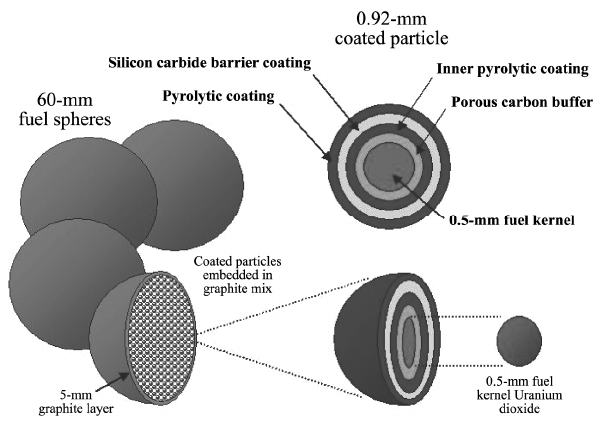
Figure 1. Graphite fuel elements in PBRs (Schaffer, 2007). Figure 1. Graphite Fuel Elements in PBRs (Scha ff er, 2007).